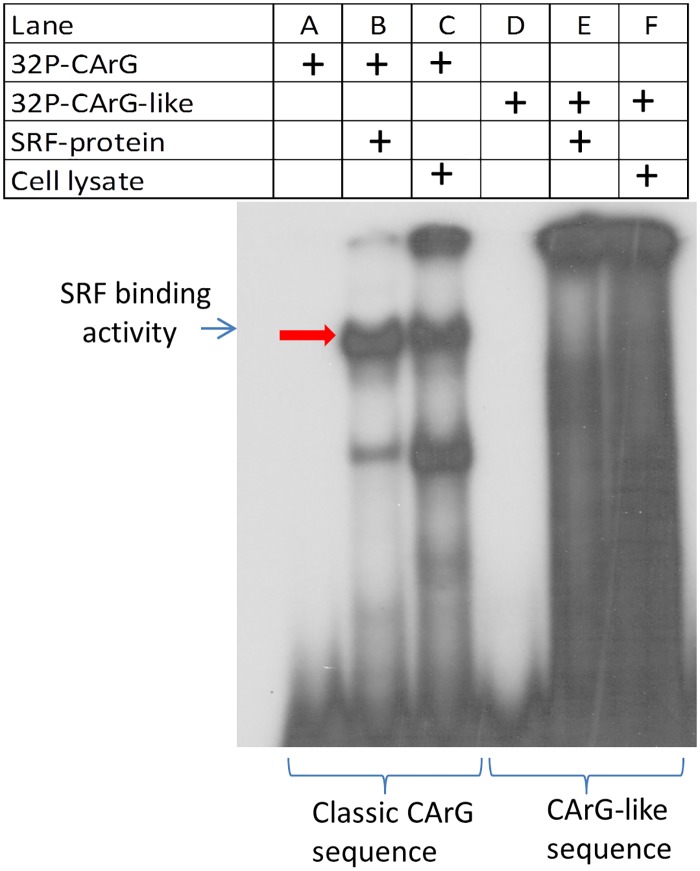
Electrophoretic mobility shift assay (EMSA) confirms that SRF protein binds to SIRT2 promoter sequence containing the classic CArG box (CCATAATAGG).To ensure that it is the SRF protein that binds to hSIRT2 CArG sequence, in-vitro synthesized SRF protein was used in the binding assay. EMSA indicates that purely synthesized SRF protein binds to classic CArG box (32P-CArG, lane b), but SRF does not bind to CArG-like sequence (CAATAAAAGG)(lane E) in which a “C” is substituted with a “A”. The arrow indicates the binding activity of full-length of SRF protein to the classic CArG sequence, which is at the similar position as what was observed in our previous experiments [33].